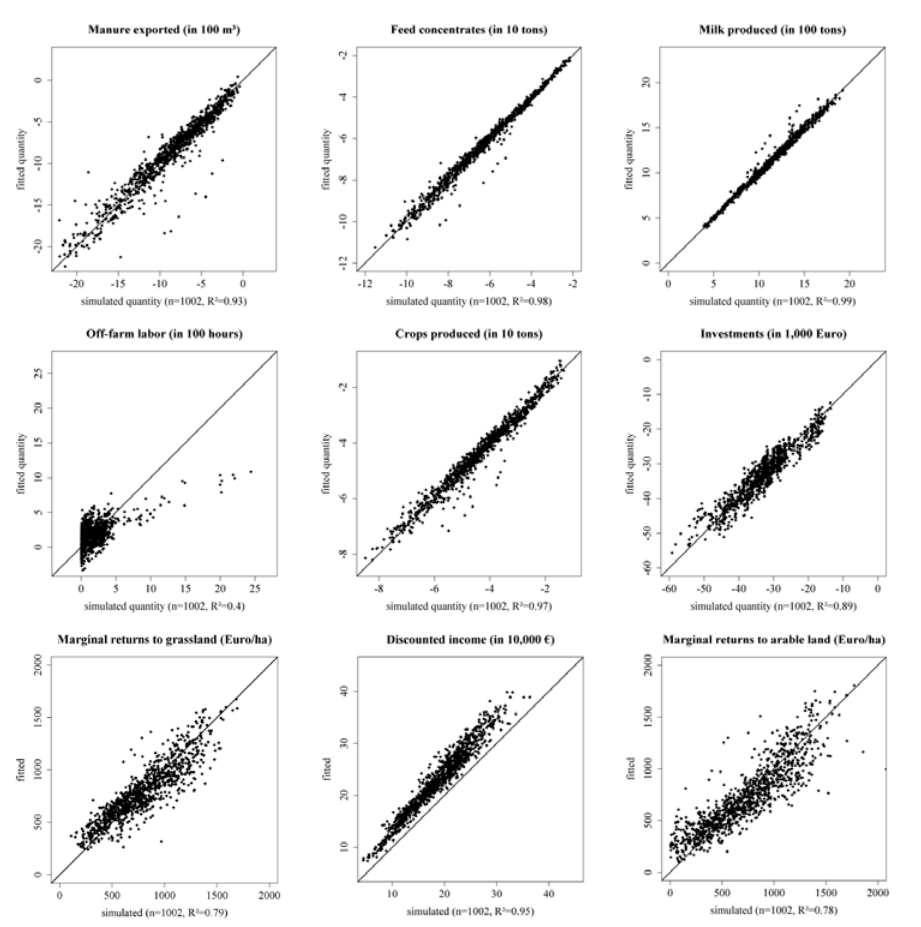
Figure 5. Scatterplots of the dynamic